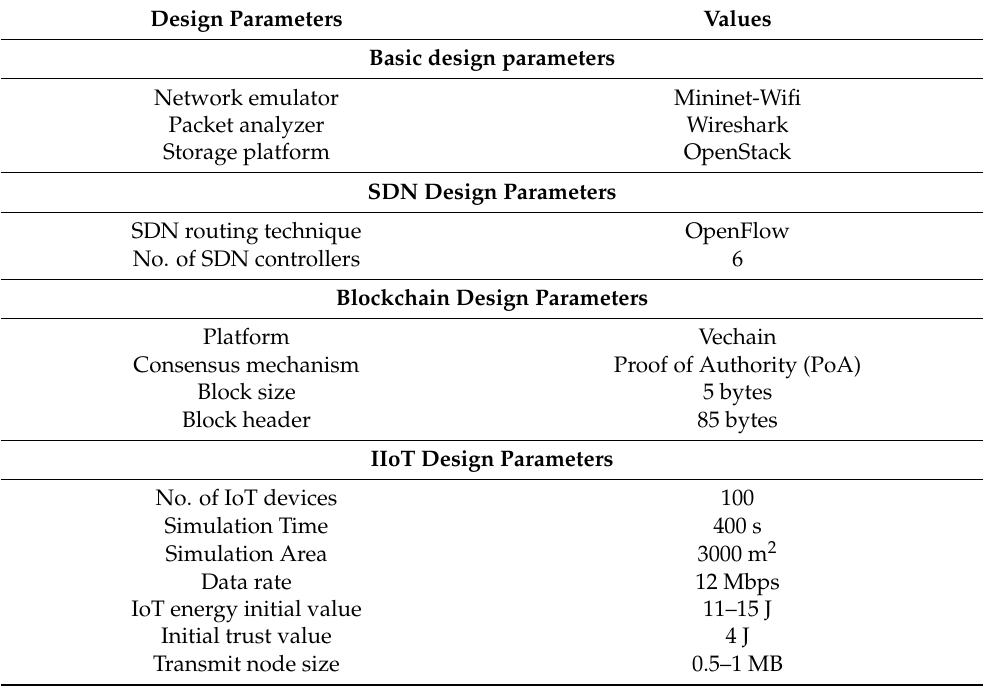
Table 2. Design Parameters of simulation environment.